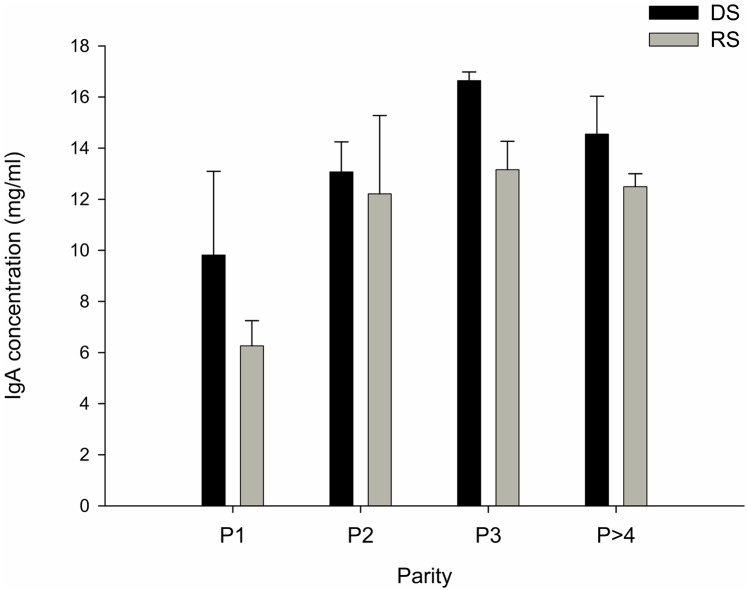
IgA concentration (mg/ml) in colostrum of sow.DS sows are represented with the black bar (N = 12) and RS sows with grey bars (N = 11) sows. Results are expressed as mean+SEM.